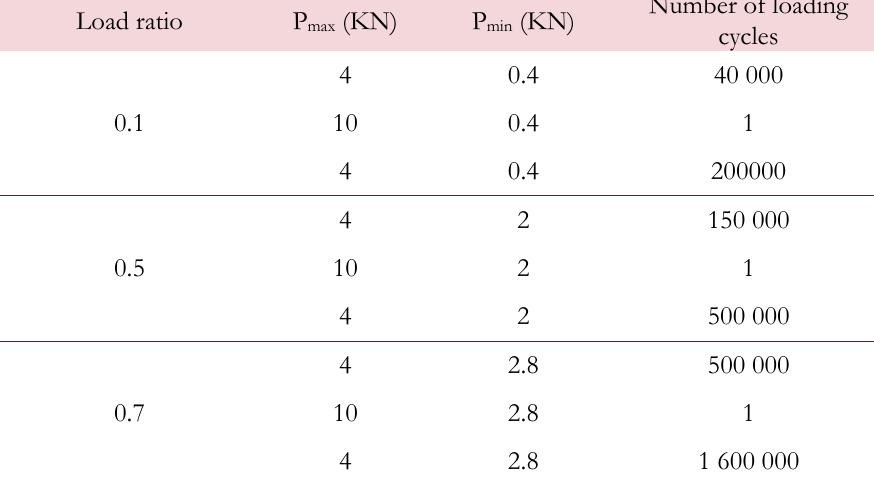
Table 3: Loading